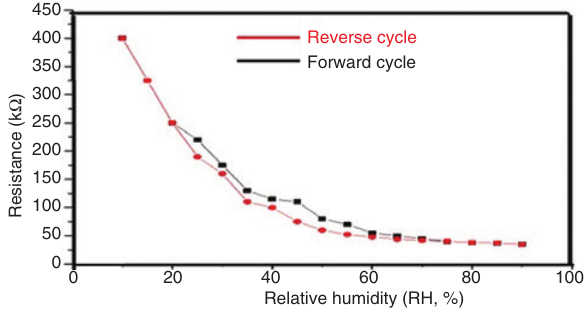
Figure 9: Measurement of hysteresis loop of sensor.